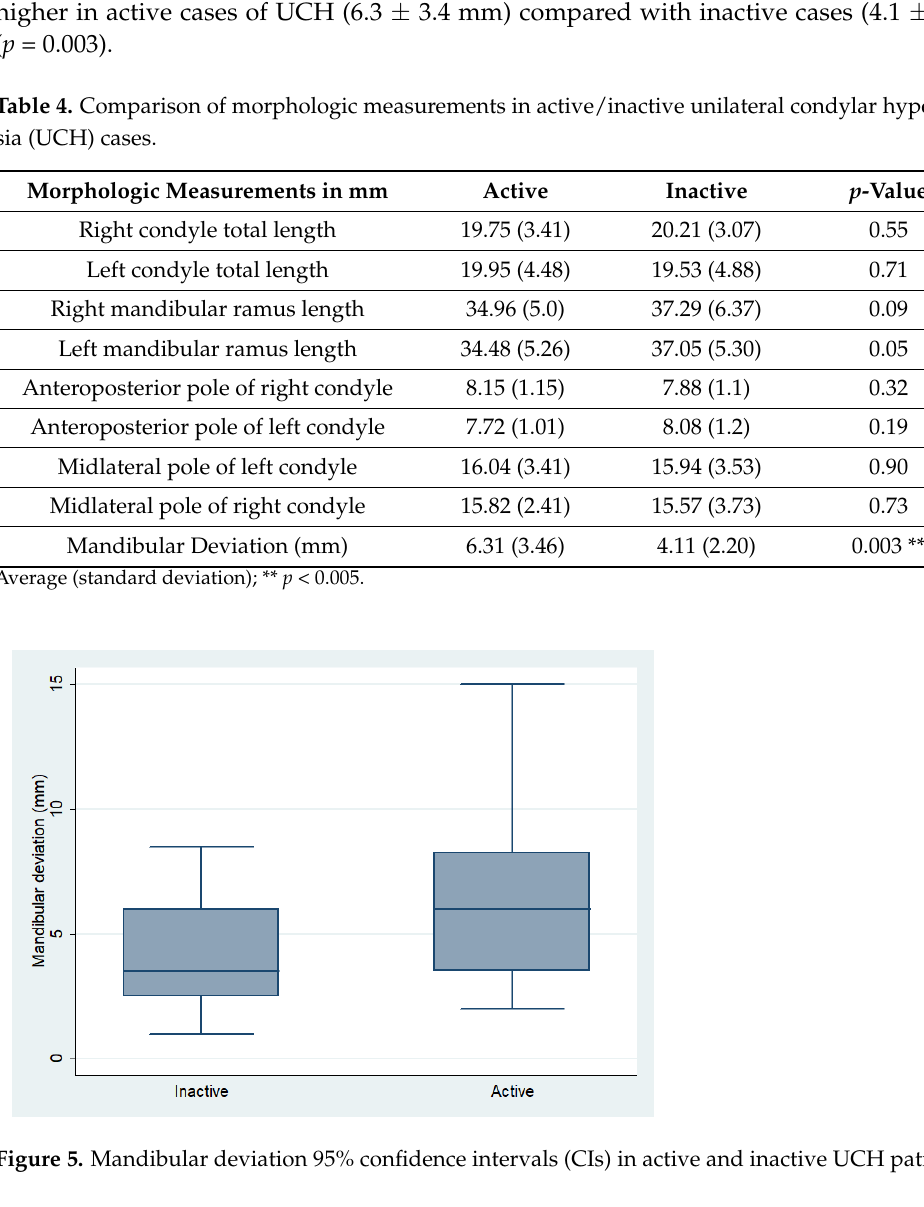
Table 3 . General characteristics of the patients with active/inactive condylar hyperplasia. SPECT, single photon emission computed tomography.